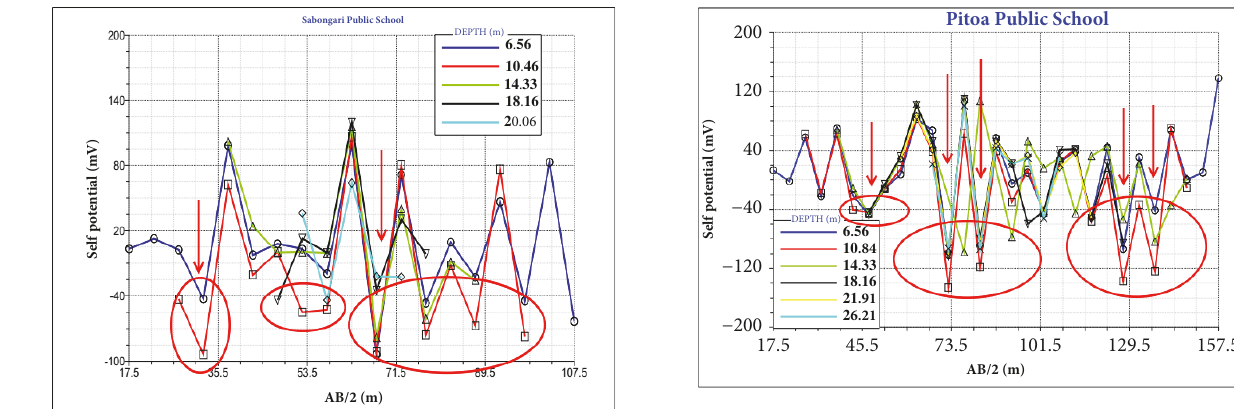
Figure17:PlotsofSPvaluesagainstHalfElectrodesSpacing(AB/2).